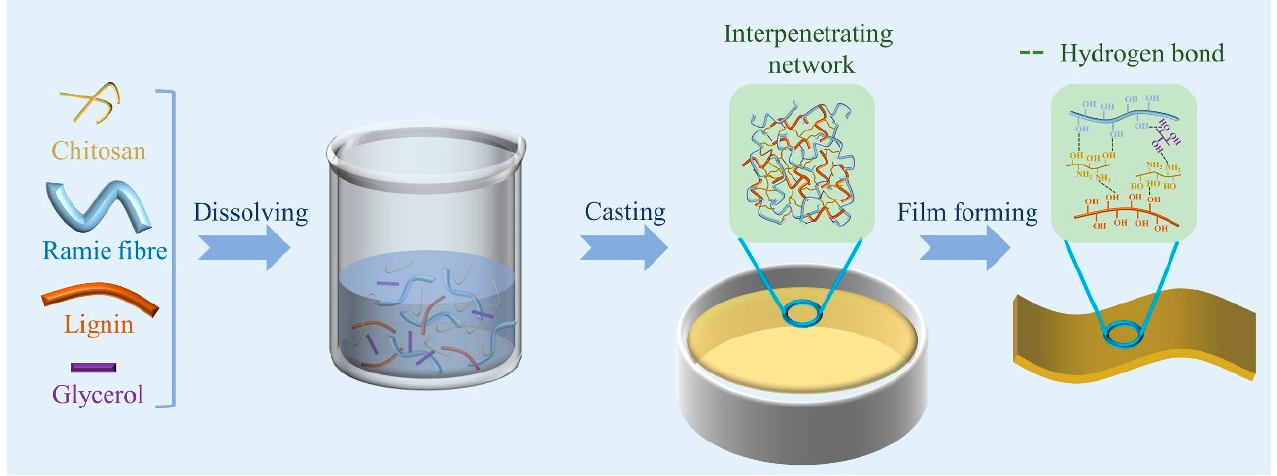
Figure 5. Preparation of chitosan/ramie fibre/lignin composite films. Reprinted with permission from [139]. Copyright 2022 Elsevier Ltd.